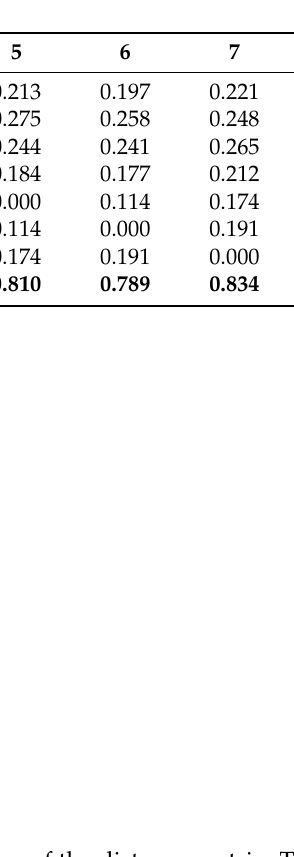
Table 3. The distance matrix of each normal dataset (k = 2).